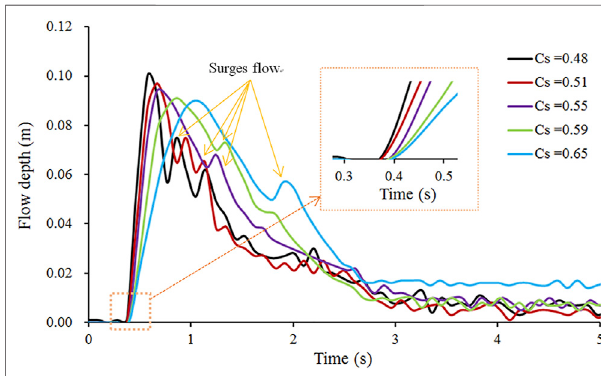
FIGURE5| The fl owdepthofdifferentsolidfractionsofdebris fl owatthe 1-1